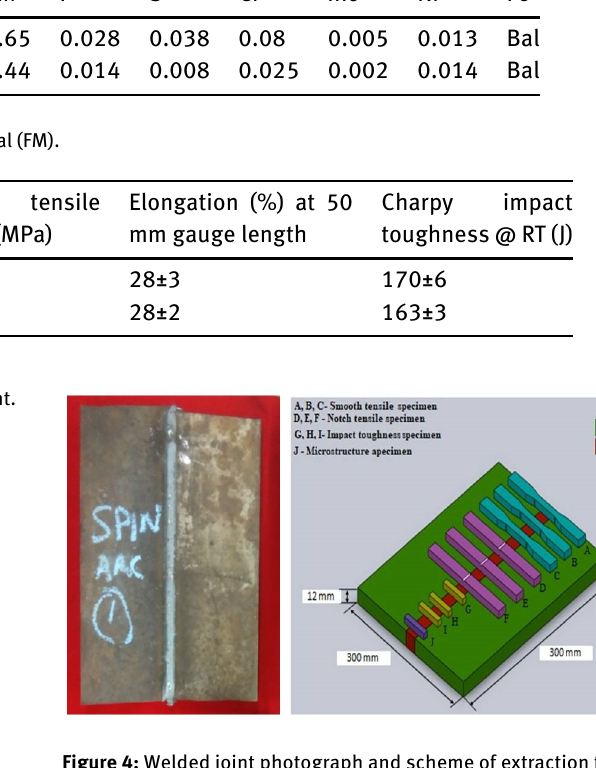
Table 1: Chemical composition of base metal (BM) and filler metal (FM). Material